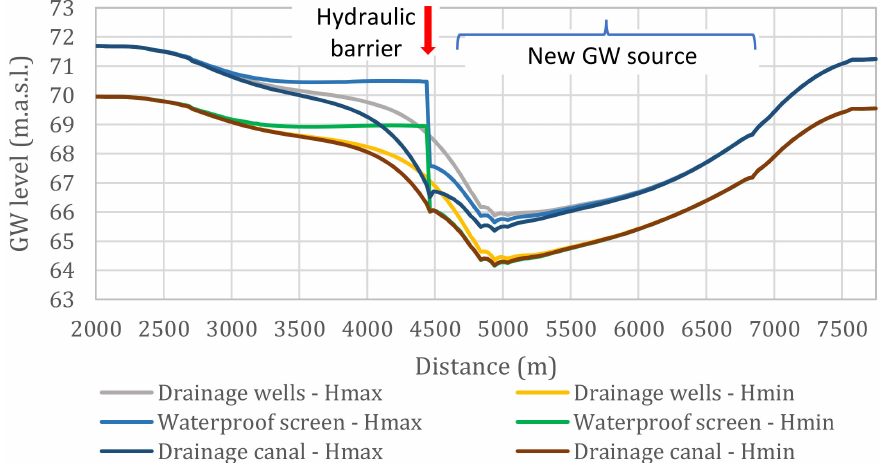
Figure 19. Groundwater levels along section A–B (see Figure 2) in the three studied pollution prevention scenarios.